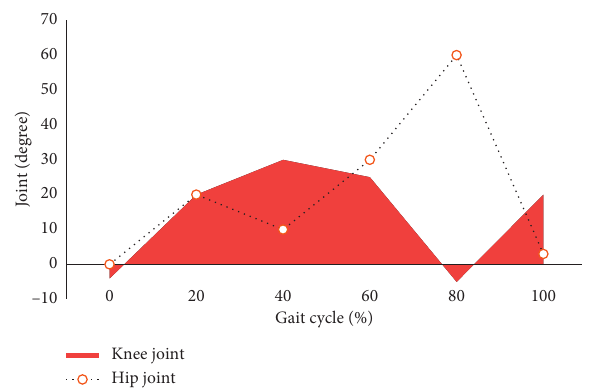
Figure 3: Expected joint trajectory of lower limb exoskeleton robot in sagittal